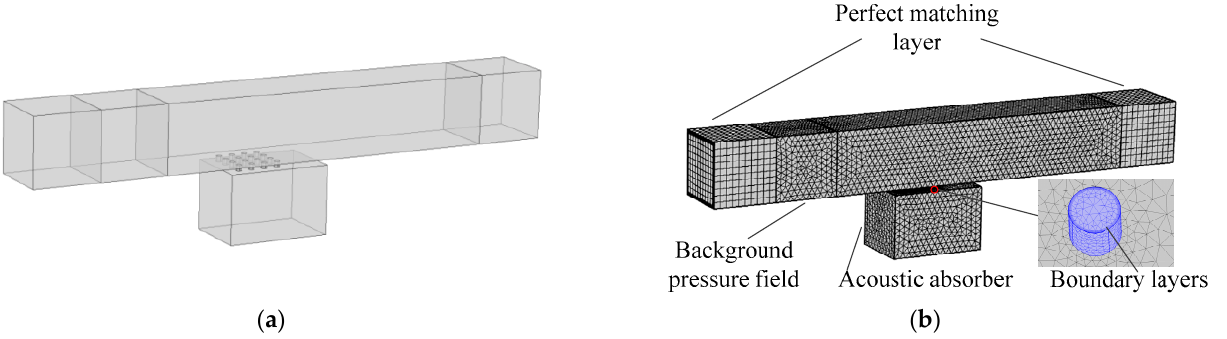
Figure 5. RDBRE system with grazing flow (suitable for the FNSE method). ( a ) geometric model. and ( b ) FE model.